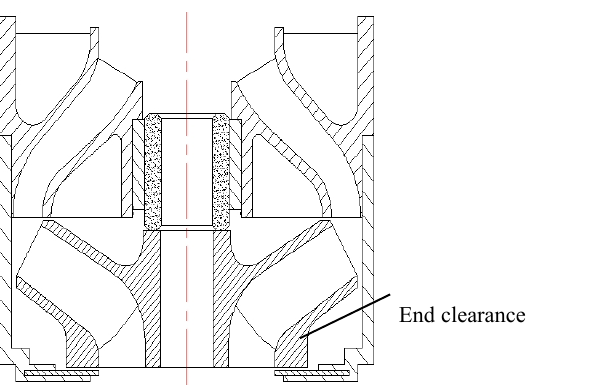
Figure 1. Simple diagram of pump section model and end clearance.